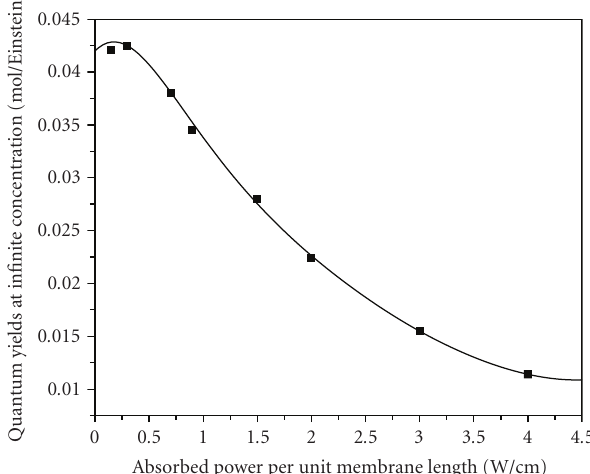
Figure 5: Quantum e ffi ciencies Φ ∞ (mol/Einstein) for photocat- alytic mineralisation of DCP in aqueous solution, by photocatalytic membranes immobilising titanium dioxide, extrapolated by (5), at “infinite” concentration of substrate, evaluated as mean values (black dots), relative to measurements of kinetic parameters reported in Table 1, as a function of absorbed power per unit length of irradiated photocatalytic membrane, expressed as W · cm − 1